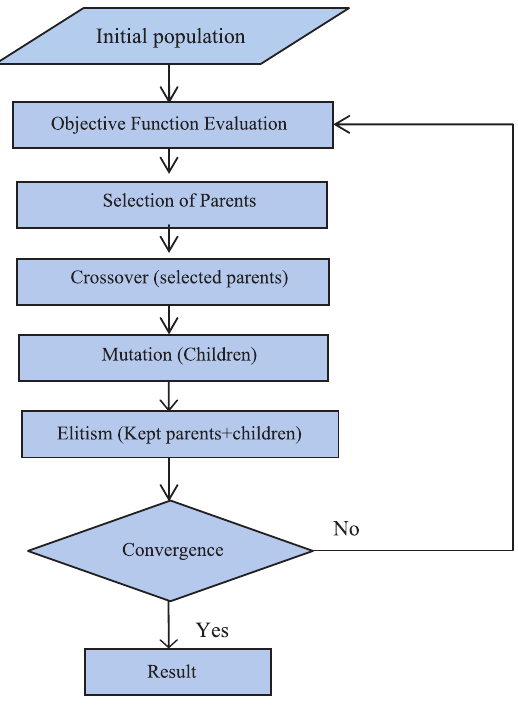
Figure 3. Flow chart showing the genetics algorithm (GA)-based inversion method.